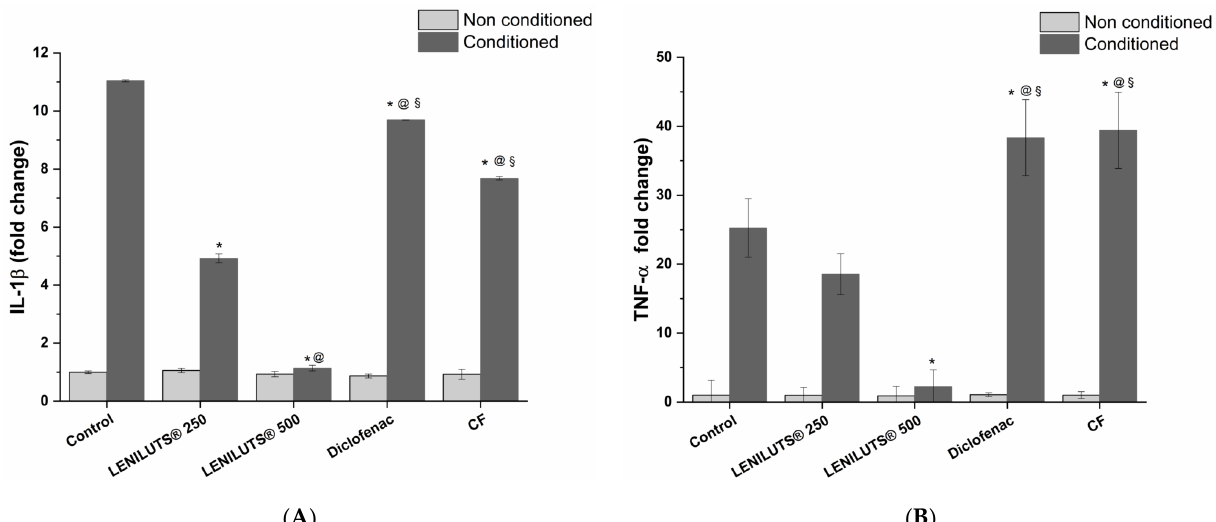
Figure 2. IL- 1β ( A ) and TNF- α ( B ) release variation in inflamed LNCaP-based in vitro prostate model before and after treatment with LENILUTS ® , CF and Diclofenac (positive control). compared to control (Ctrl; untreated LNCaP cells). * p < 0.05 vs. control, @ p < 0.05 vs. LENILUTS 250, § p < 0.05 vs. LENILUTS 500.